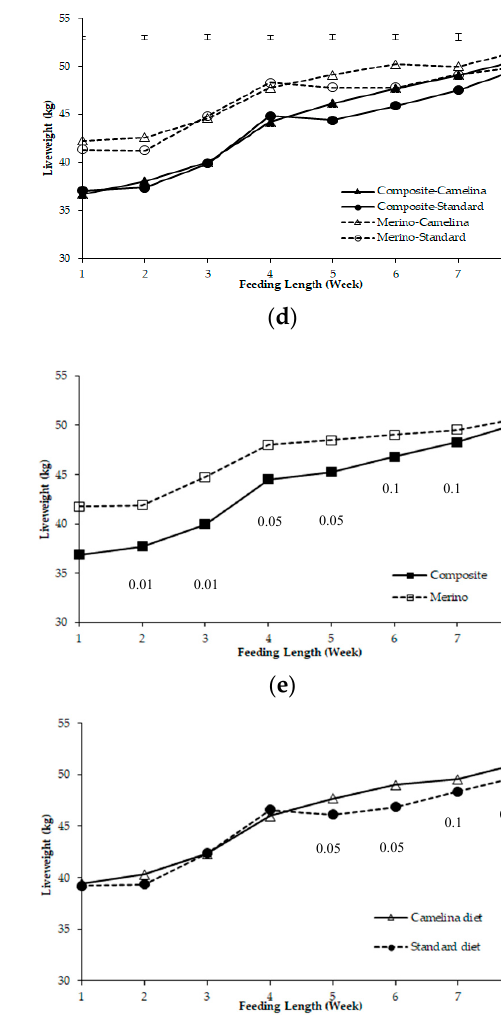
Figure 2. Comparison of air temperature and temperature-humidity index (THI) between the ani- mal house (black line) and Hamilton, Victoria weather station (grey line) on the hottest day of the experiment (36 °C, 8 February 2017, ( a , b )) and on a day with a maximum of 27 °C, 7 March 2017, ( c , d )).